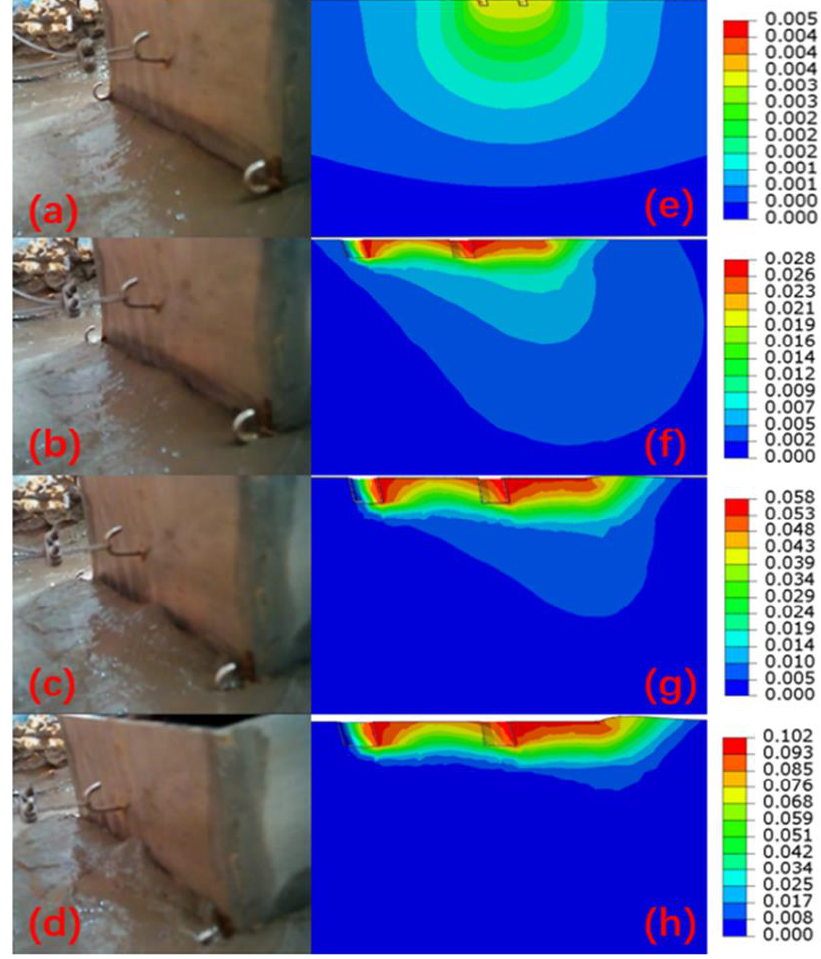
Figure 12. Soil deformation diagram of model test and numerical simulation: ( a , e ) are soil defor- mation diagrams when the gravity anchor moves 0 mm, ( b , f ) are soil deformation diagrams when the gravity anchor moves 25 mm, ( c , g ) are soil deformation diagrams when the gravity anchor moves 50 mm, and ( d , h ) are soil deformation diagrams when the gravity anchor moves 75 mm.